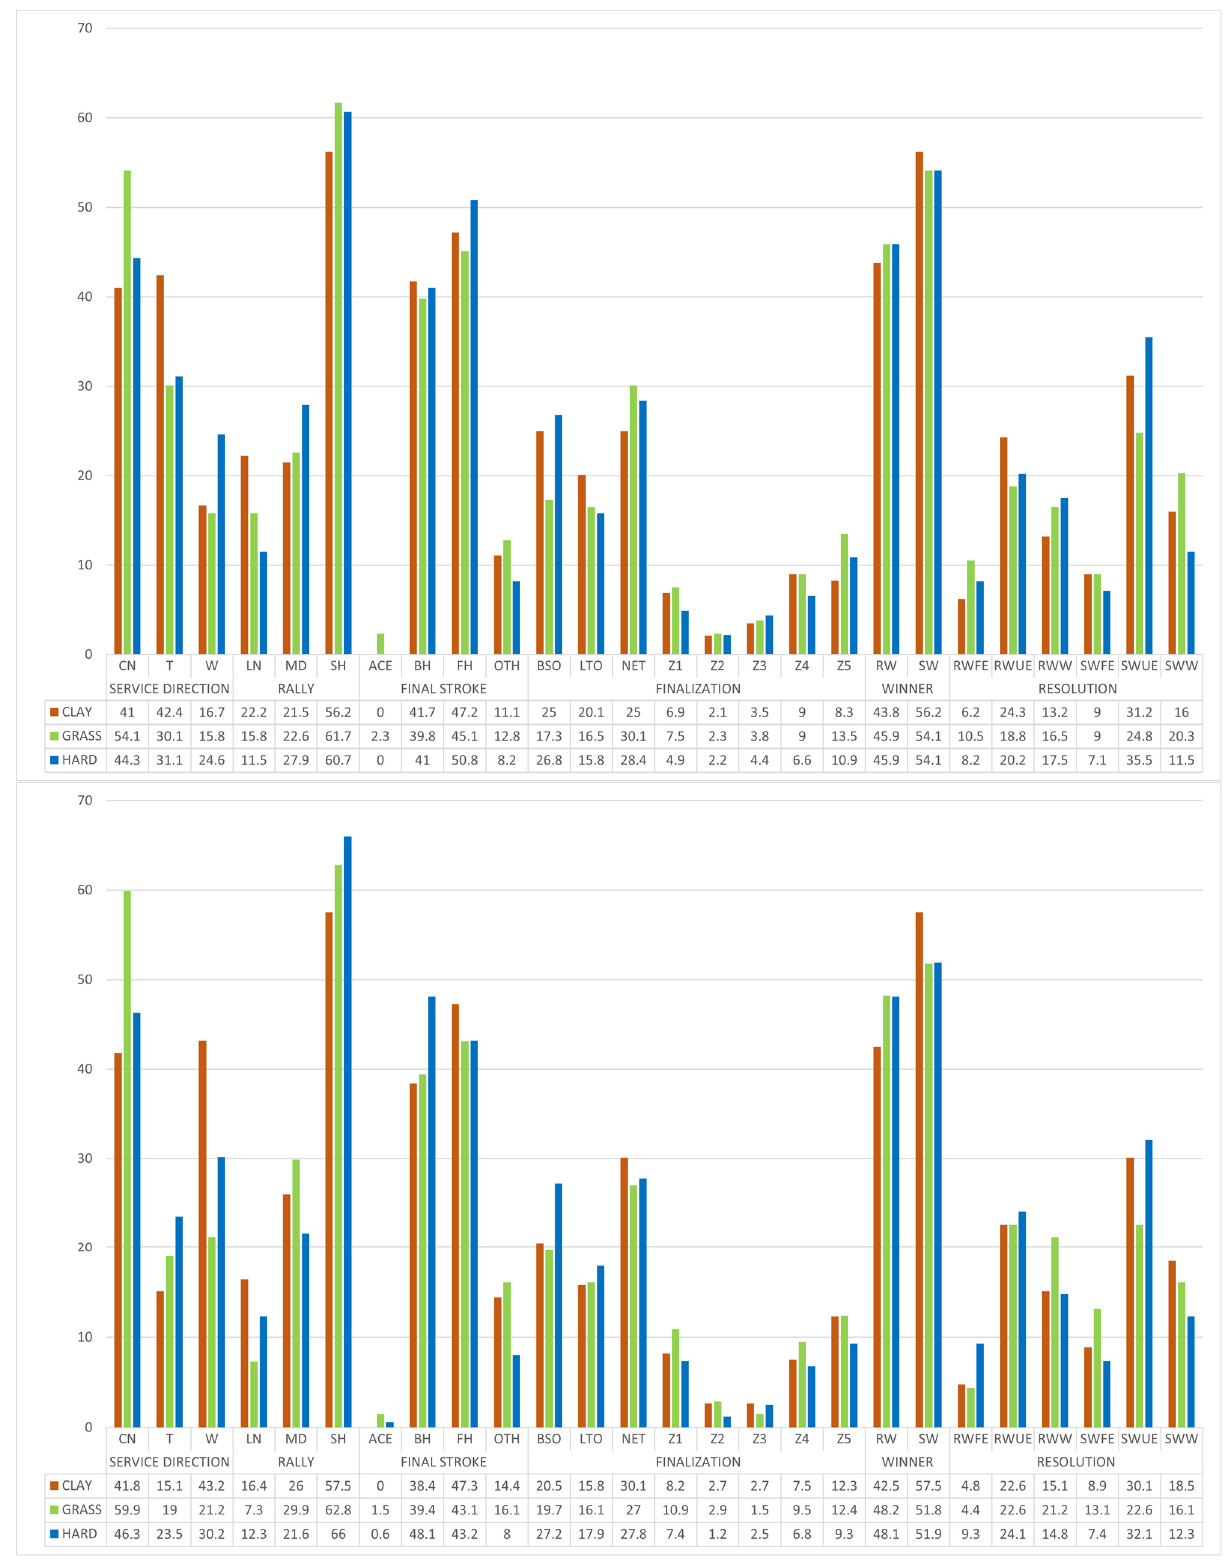
Figure 4. Distribution of the points played with second service to the deuce and the advantage